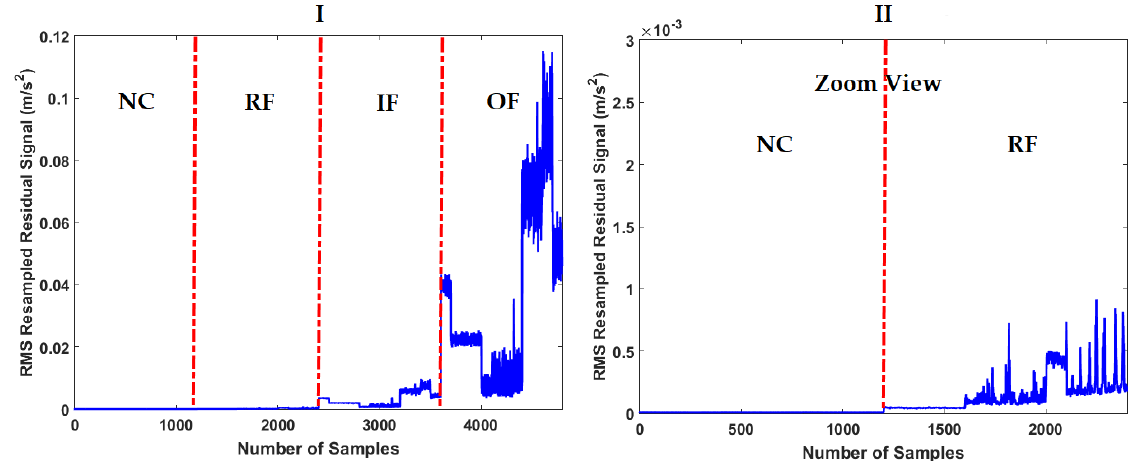
Figure 6. The RMS resampled residual signals using the proposed ADT algorithm: (I) for the NC, RF, IF, and OF and (II) zoom view.